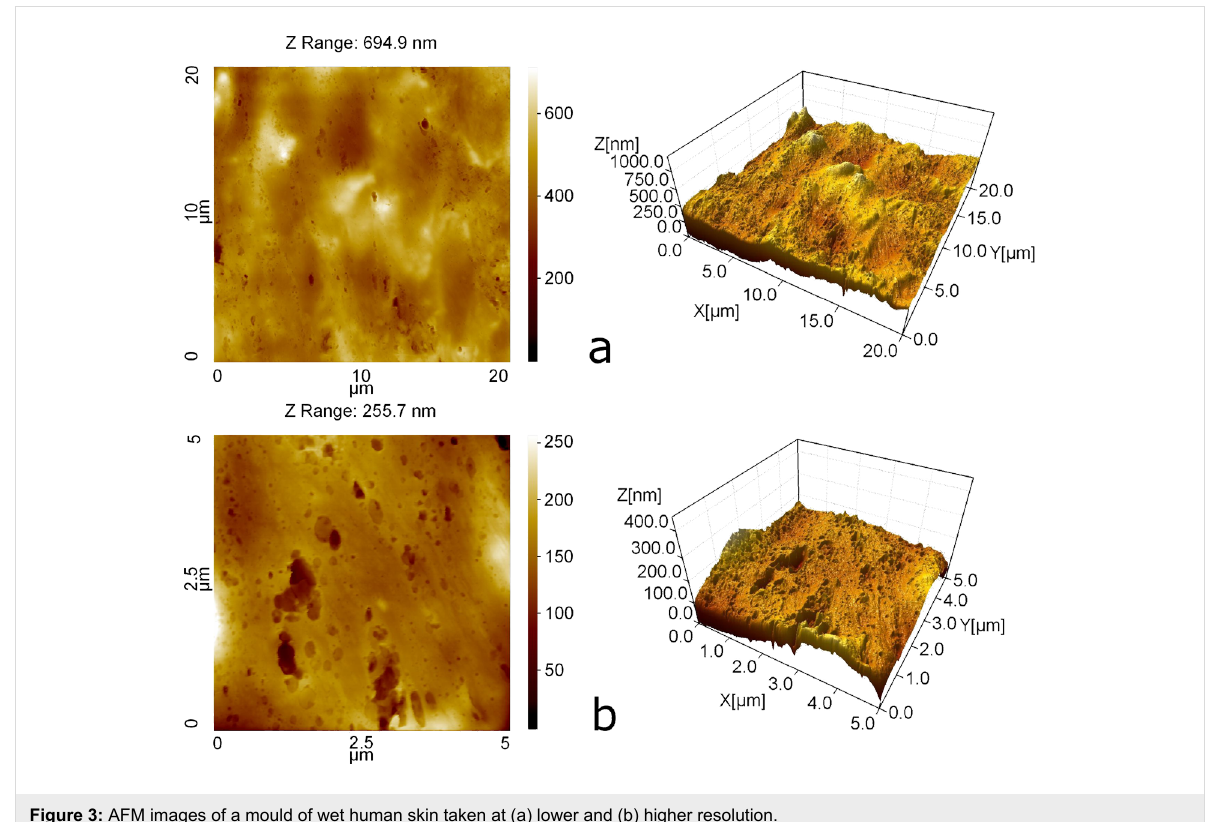
Figure 3: AFM images of a mould of wet human skin taken at (a) lower and (b) higher resolution.